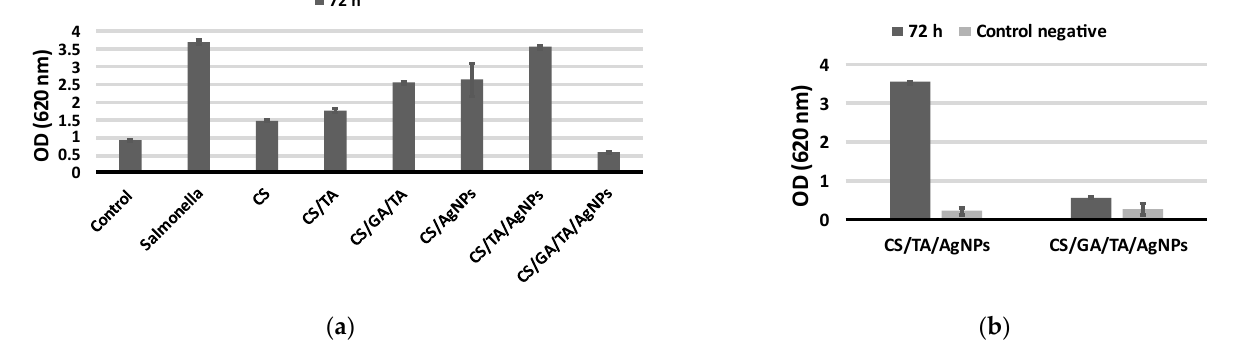
Figure 7. Graphical representation of the optical density (OD) of Salmonella enterica biofilms and control samples after 72 h incubation attached to the bottom of individual wells in 96-well microplate ( a ) at 620 nm derived from the ethanol elution of the crystal violet stain; ( b ) comparison of OD values of treated biofilm and control negative measurements of polymer blend without bacteria for the same incubation conditions. Error bars represent statistical analysis based on triplicate measurements.